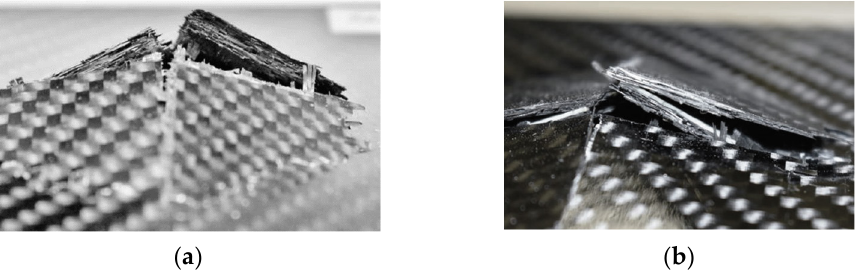
Figure 6. Breaking zones of sandwiches with damping material after the impact test: Kraibon SUT ( a ) and Kraibon HHZ ( b ).